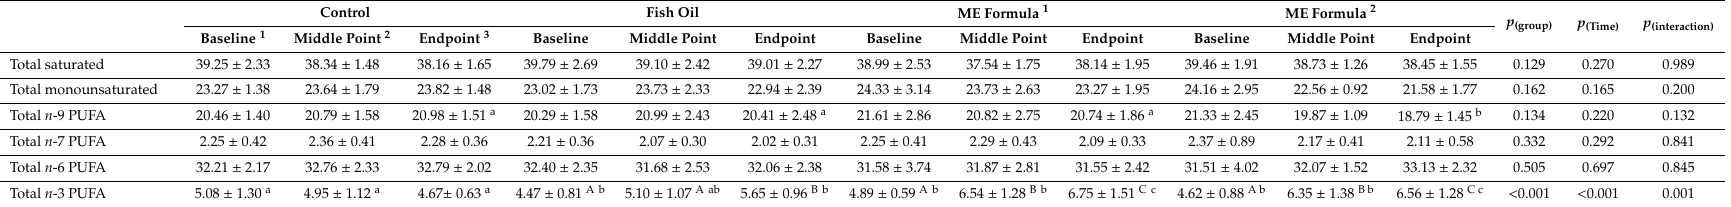
Table 3. Mean whole blood fatty acid levels (%) in toddlers fed in toddlers fed di ff erent formulas.